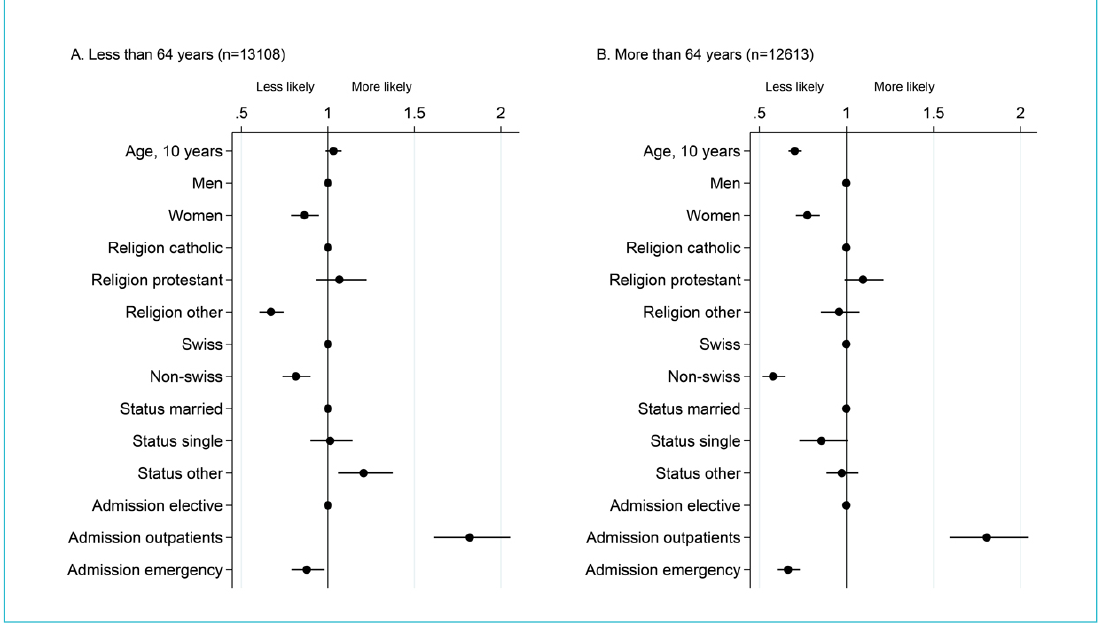
Figure 2: Factors associated with willingness to participate among 25 721 patients . Dots represent odds ratios and bars 95% confidence intervals from a multivariable logistic model including willingness to participate as the dependent variable, run separately in the two age strata. The age cut off at 64 years was chosen as it is close to the median age and happens to closely match the retirement age in Switzerland. Pa- tients aged <64 years are depicted in Panel A, and those aged 64 or older are shown in Panel B.